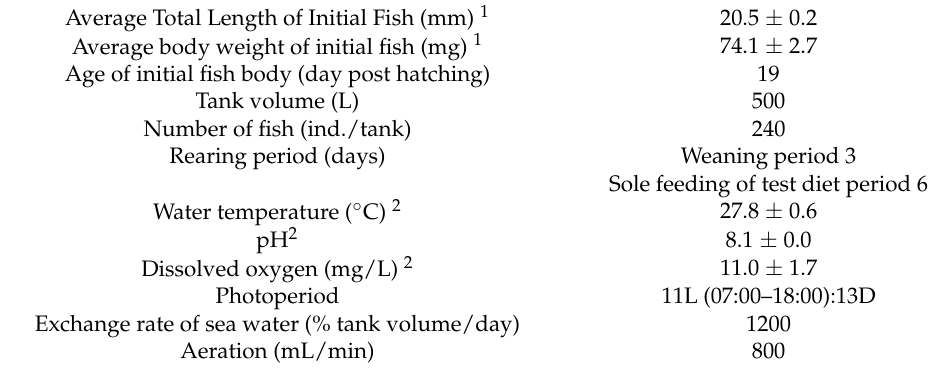
Table 5. Rearing conditions for feeding trial of Pacific bluefin tuna